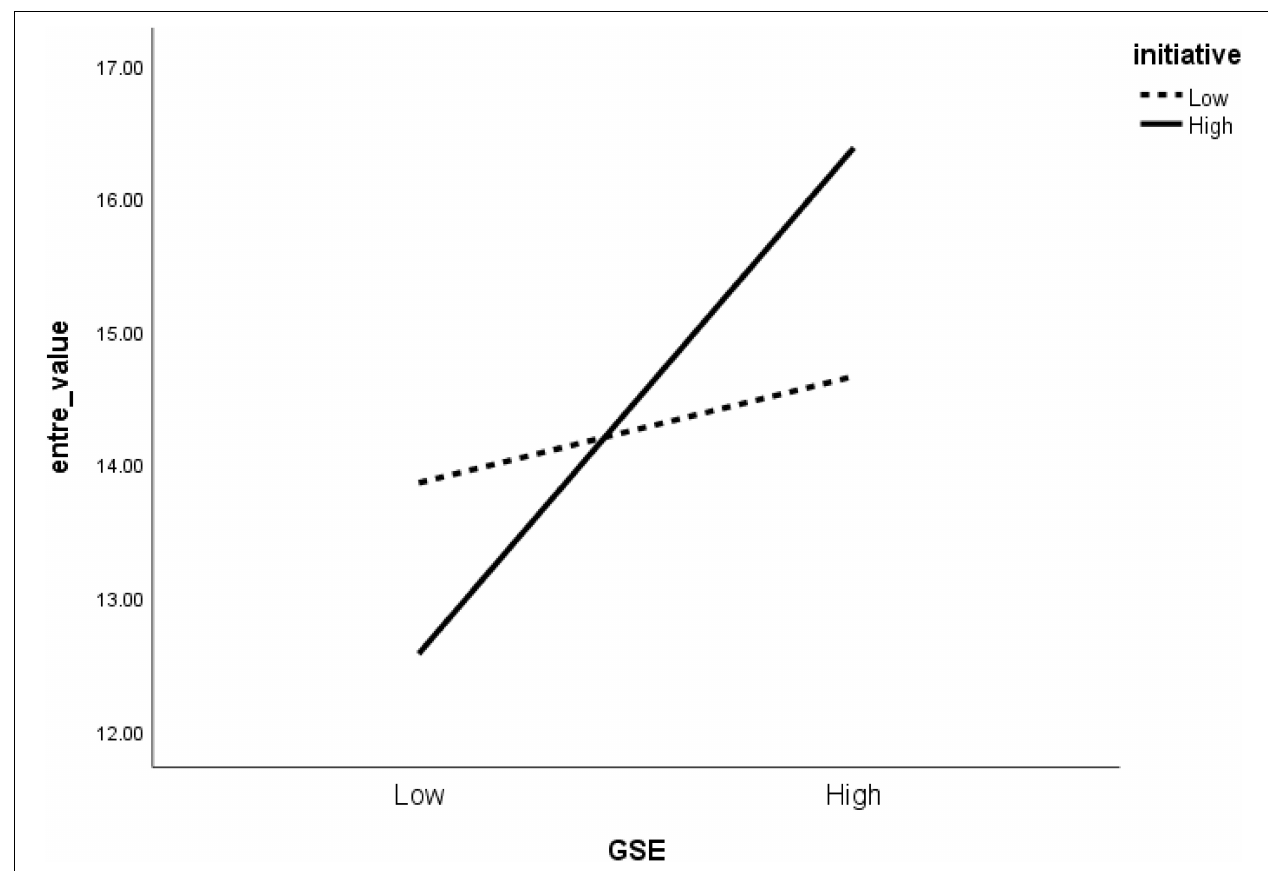
FIGURE 2 | Moderating effect of initiative on the relationship between GSE and entrepreneurial intention